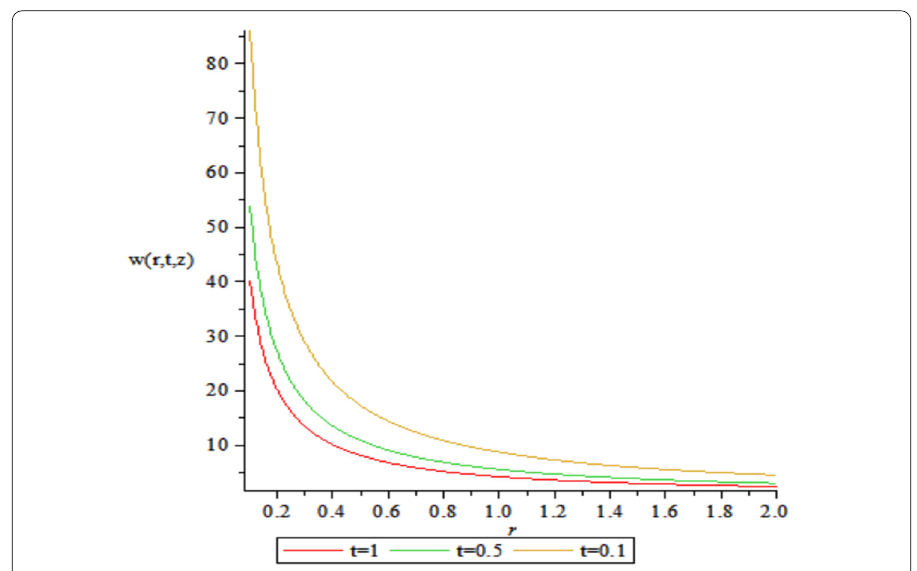
Figure 1 Velocity component w ( r , t , z ) at z = 2, c 3 = 1, and c 4 = 1